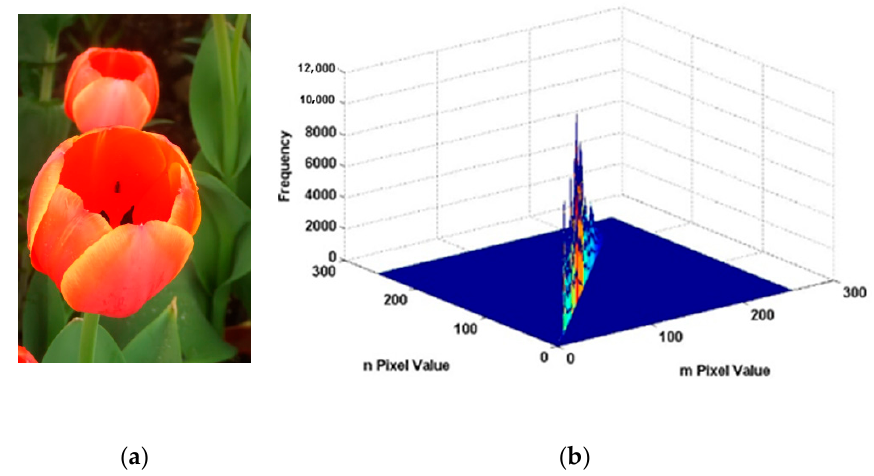
Figure 1. CCH of a tulip image: ( a ) an original image, ( b ) CCH of a grayscale image.